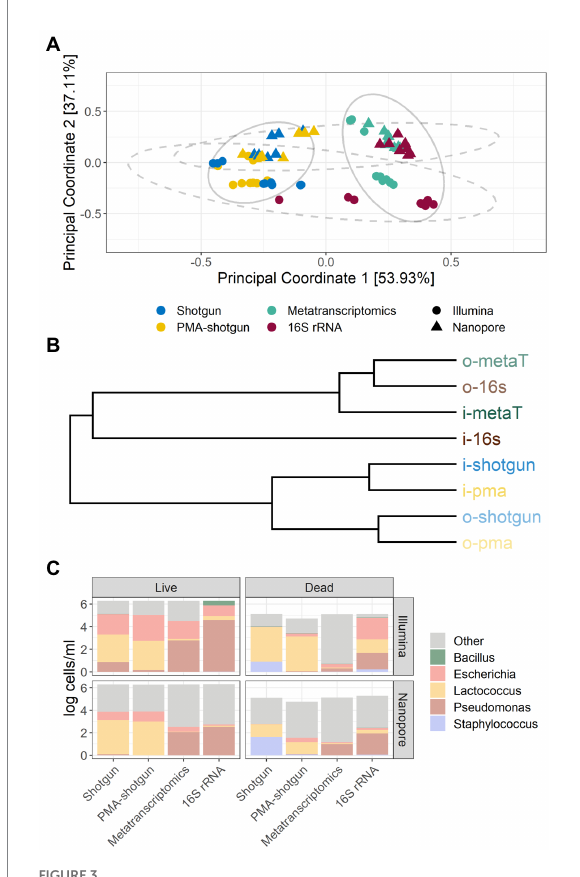
FIGURE 3 Beta diversity and taxonomic profiles of samples. (A) Bray-Curtis principal-coordinate analysis (PCoA) plot, with ellipses representing clustering by DNA- and RNA-based methods (solid) and sequencing method (dashed) and (B) hierarchical clustering of methods based on Bray-Curtis distances. (C) Composition of taxa in samples based on live or dead spiked model community, by the evaluated methods and sequencing